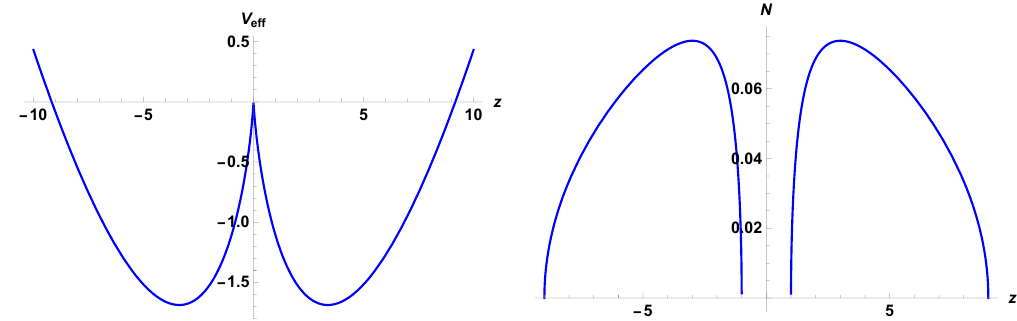
Figure 2 . In the left plot we depict the typical effective potential for large ξ eff = ξR − R/ 2 (two deep wells) and in the right one the typical density of boxes that has support on two segments in the z